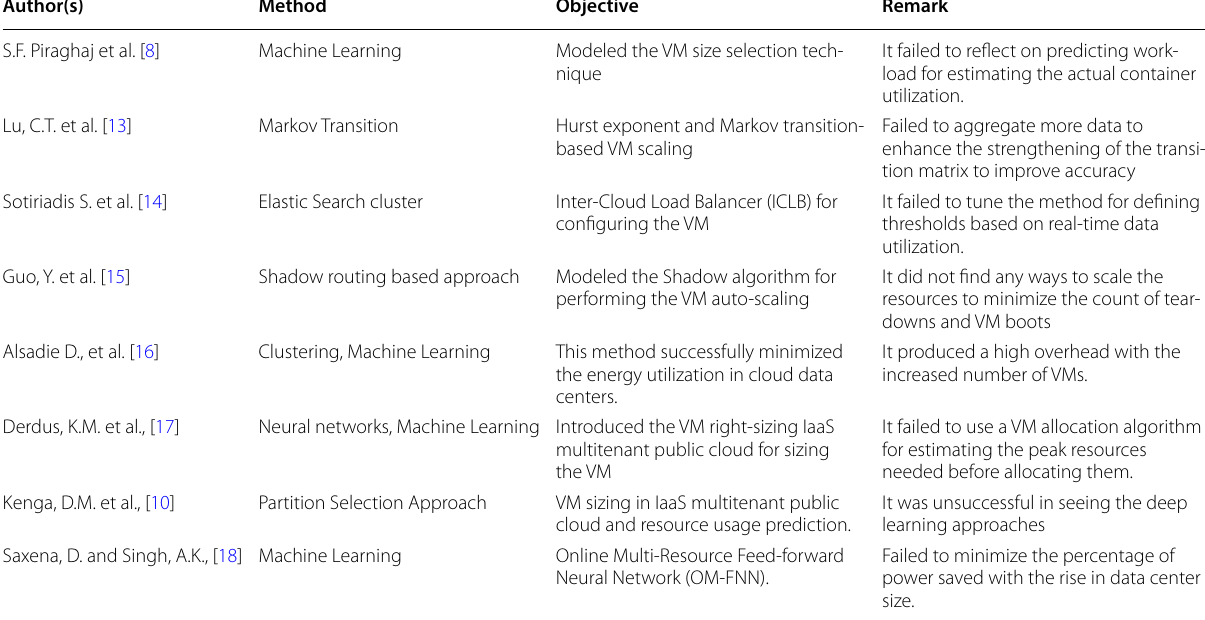
Table 1 Review of published work on virtual machine sizing and